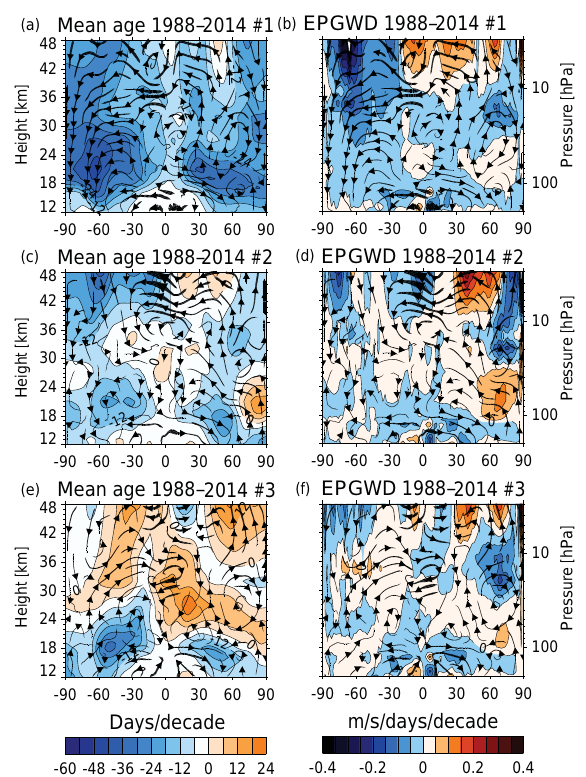
Figure 5. (left) As in Fig. 2 but for trends in mean age from 1988 to 2014 in the three ensemble members. Note that (a) corresponds to the ensemble member with decreasing mean age and (e) to the en- semble member with aging air in the NH midlatitude stratosphere. The right column shows the changes in total wave forcing of the BDC (EP flux divergence plus gravity wave